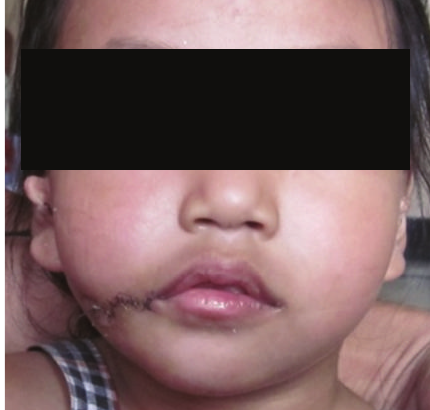
Figure 4: Postoperative photograph 7 days after surgery.